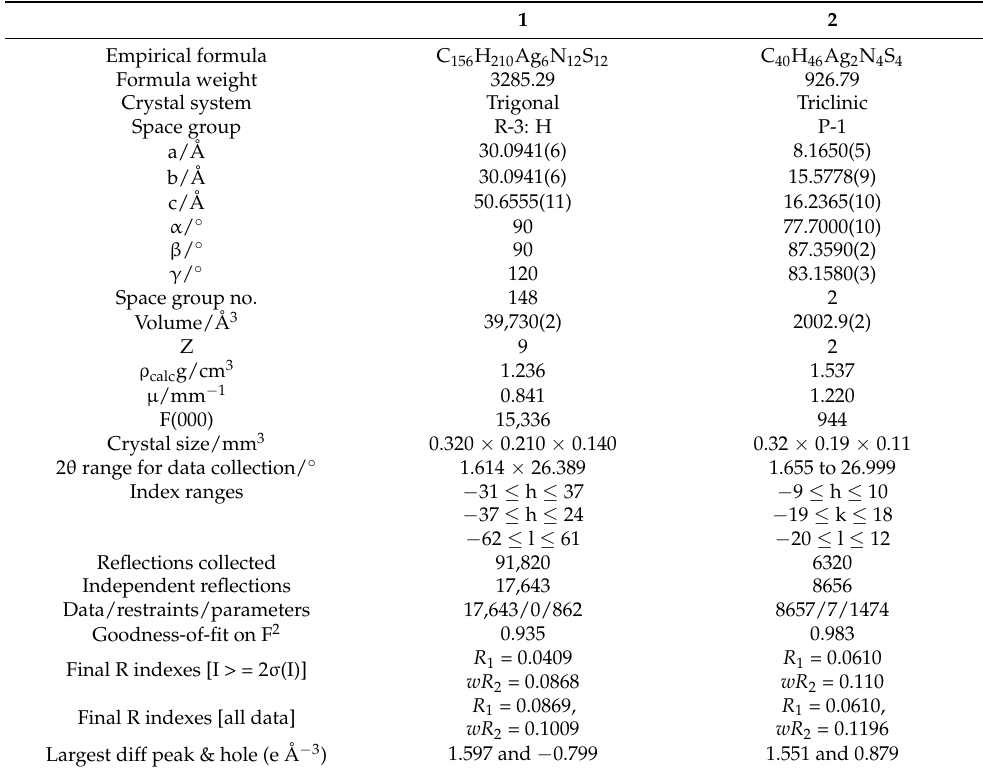
Table 1. The summary of X-ray crystal data collection and structure refinement parameters for complexes 1 and 2